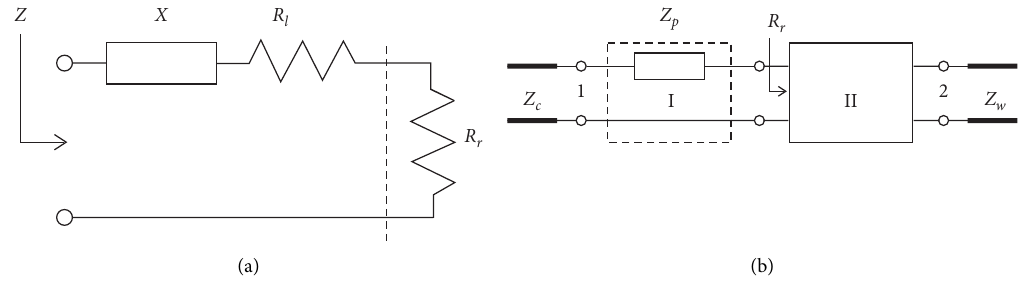
Figure 2: An equivalent circuit (a) of the dipole and its representation as a two-port network (b).